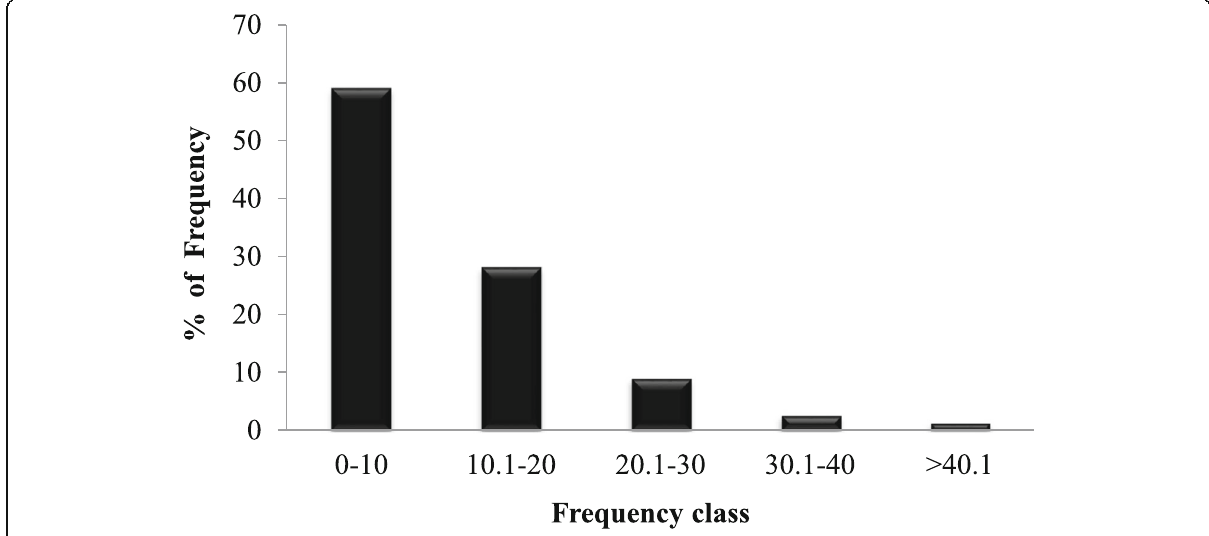
Fig. 7 Frequency distributions of trees and shrubs in the Hirmi